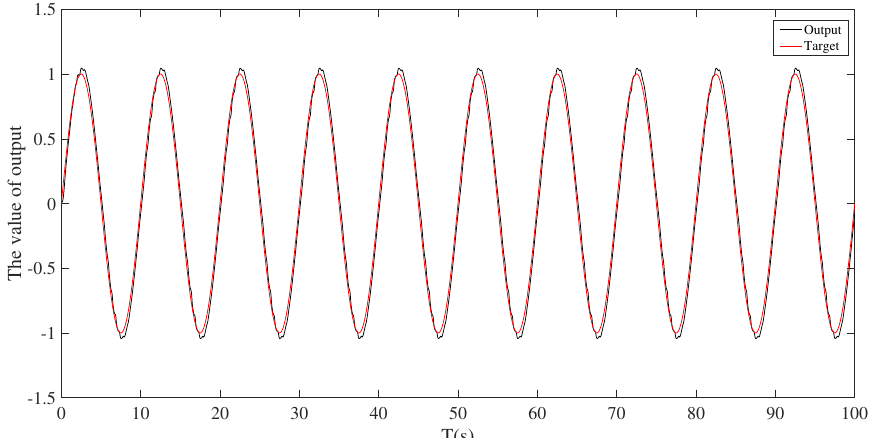
Figure 7. Output and target curves in unknown time-varying delay form (with dead-zone compensa- tion controller).